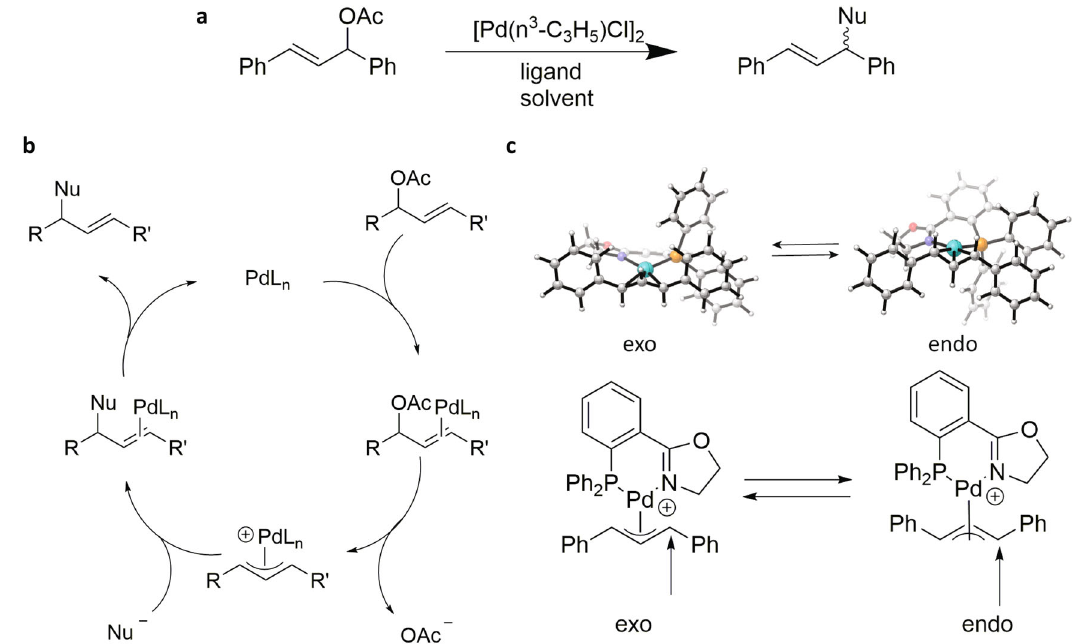
Fig. 1 Pd-catalyzed allylic amination reaction. a Reaction modeled for the TSFF being developed. b Simpli fi ed mechanism of the reaction. c Exo-endo isomerization of the